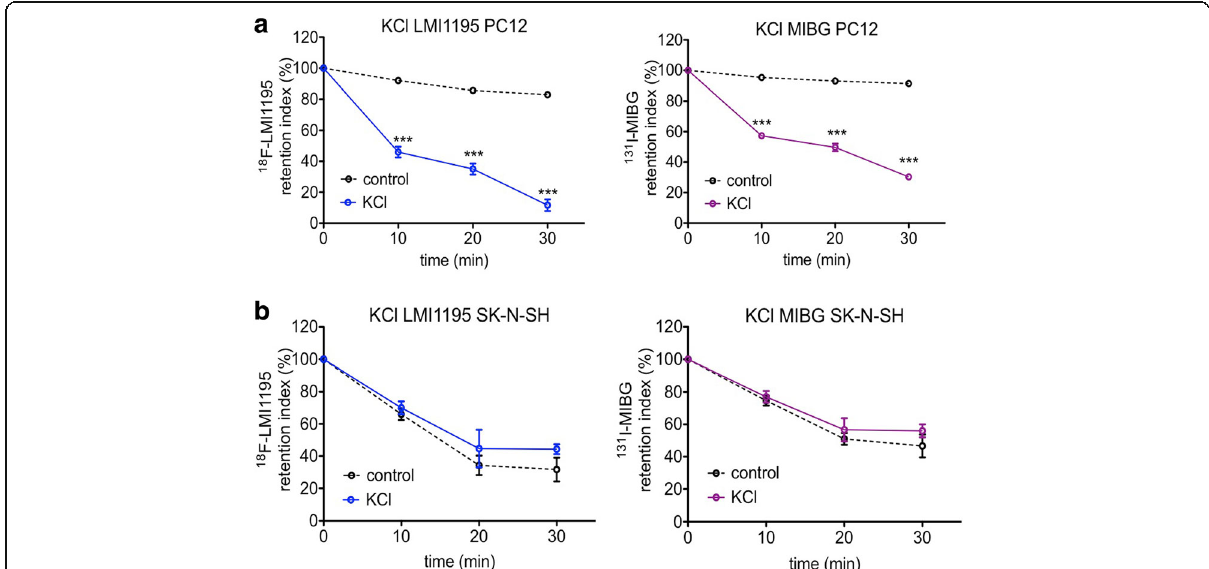
Fig. 1 Time course of tracer retention index after the stimulation with high concentration KCl buffer. Both 18 F-LMI1195 and 131 I-MIBG were induced to be released from (vesicle-rich) PC12 cells after high concentration KCl buffer treatment ( a n = 3 at each time point of both groups), whereas no such effect could be observed in (vesicle-poor) SK-N-SH cells ( b n = 3 at each time point of both groups). *** p < 0.001 vs. control group at the same time point; all data points presented as mean ± SD